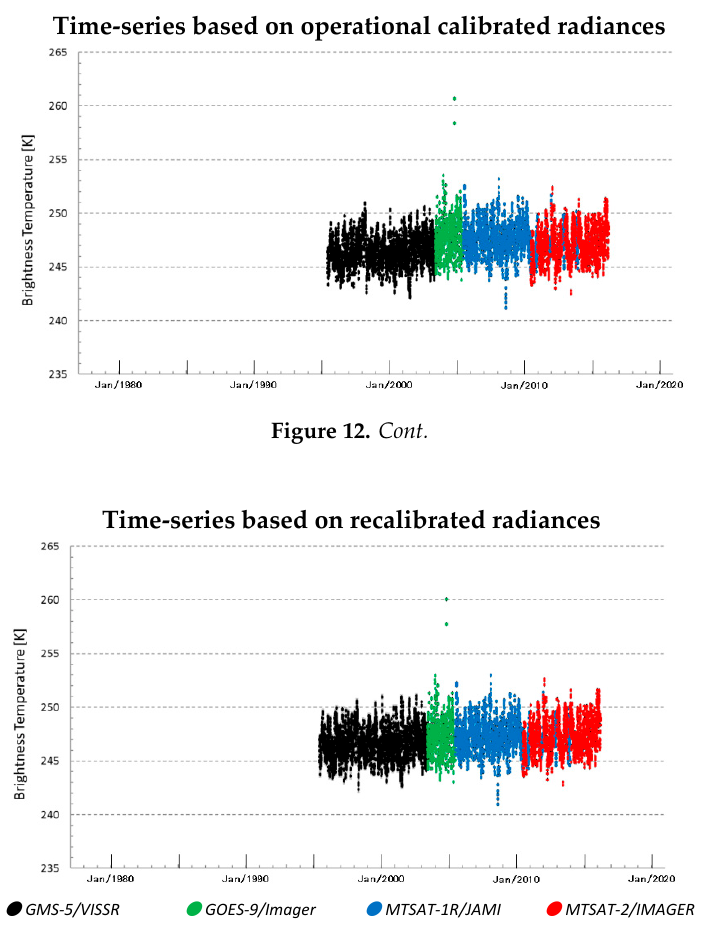
Figure 11. Time-series of baseline sensor normalized GMS, GMS-2, GMS-3, GMS-4, GMS-5, GOES-9, MTSAT-1R and MTSAT-2 clear sky radiances (presented as brightness temperatures) for the IR channel, taking MTSAT-2 as the baseline sensor. The upper panel presents the time-series using the operational calibration, whereas the lower panel presents the time-series for the recalibrated calibration. The data points represent daily average values for the area 30N–30S, sub-satellite longitude − 30 ° –sub-satellite longitude +30 ° derived from 6 hourly data. The shaded areas in the lower panel represent 1 σ uncertainty due to the recalibration.